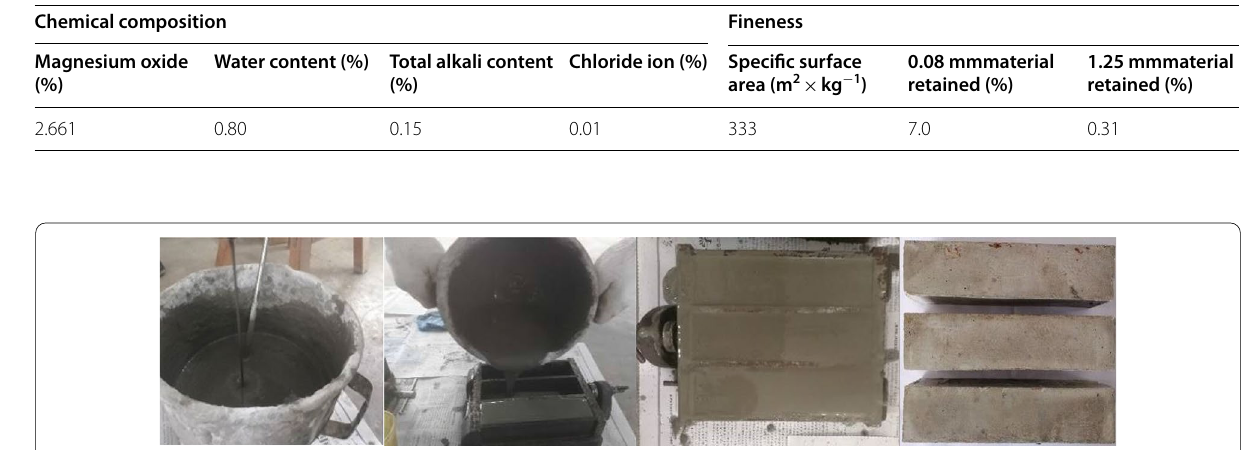
Fig. 2 Sample preparation process